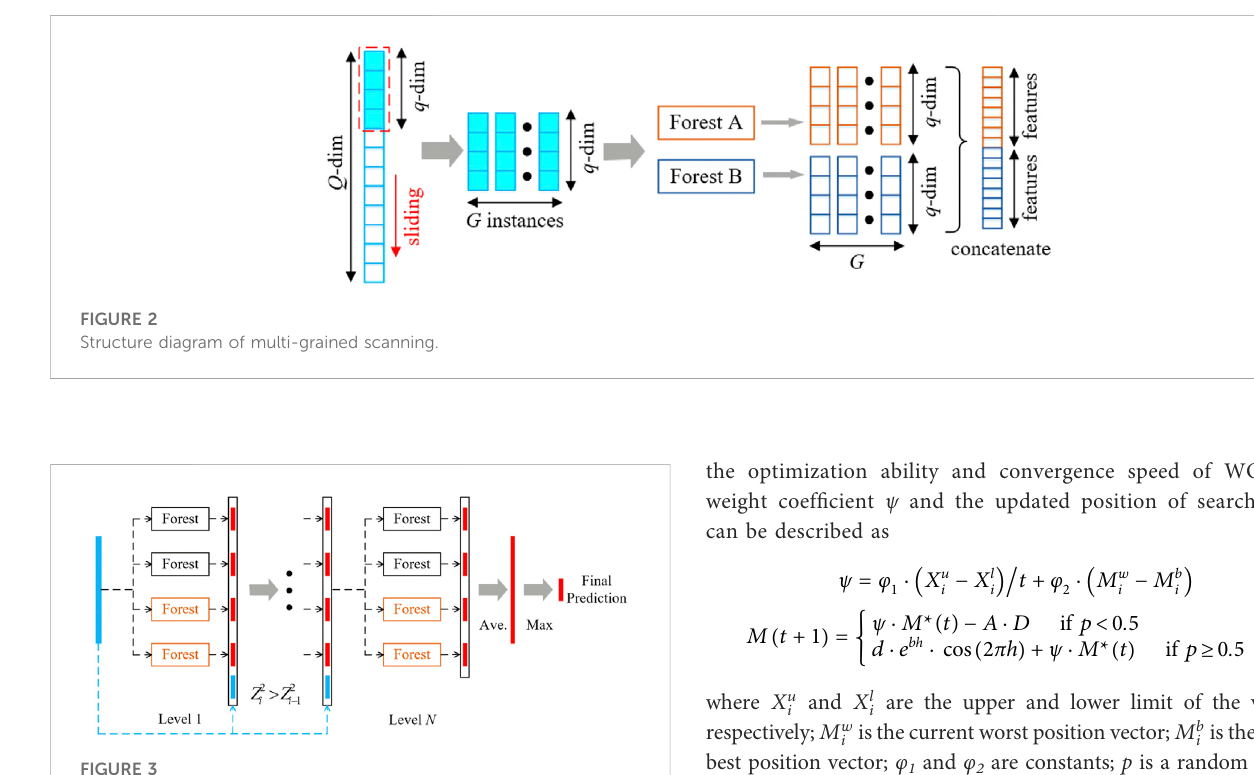
FIGURE 3 Structure diagram of cascade